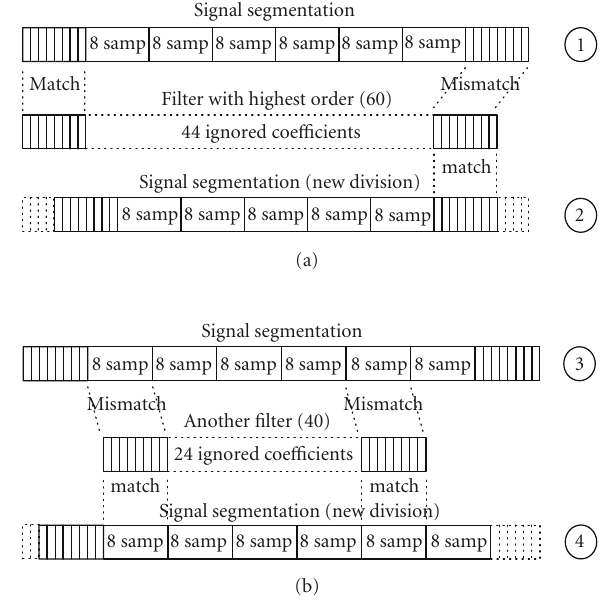
Figure 6: Strategy to adjust the filter coe ffi